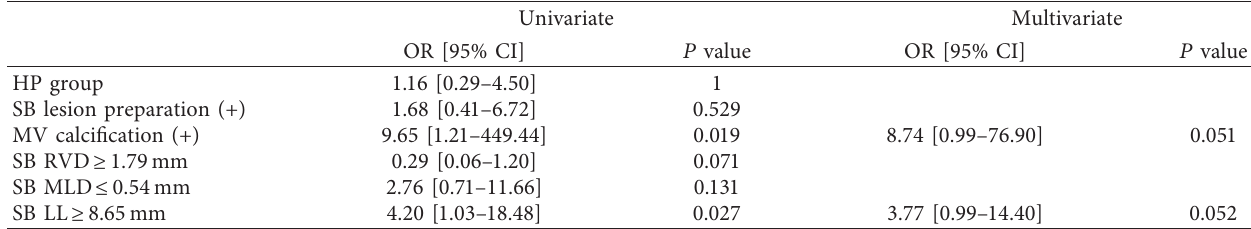
Table 5: Univariate and multivariate analysis for SB